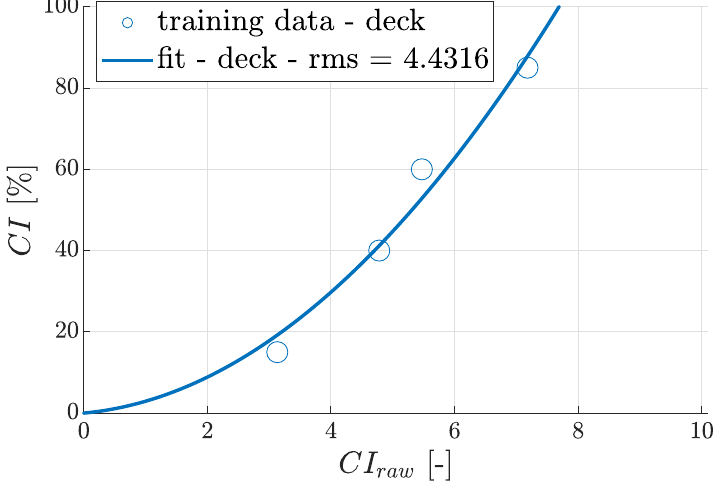
Figure 16. Comfort Index calibration